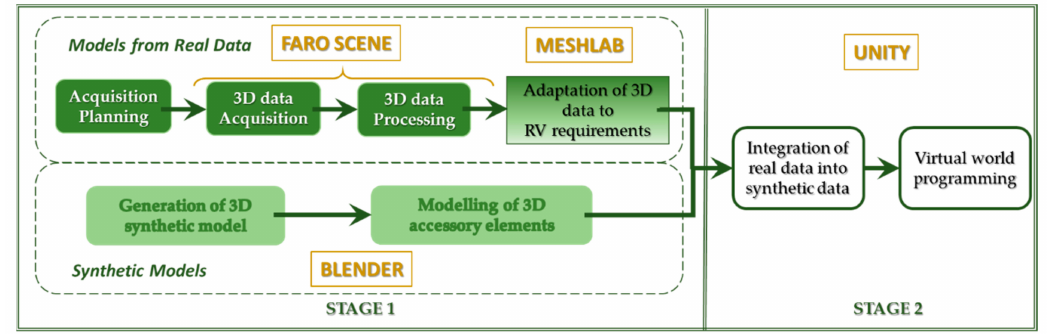
Figure 2. Scheme of the procedure performed to build the virtual reality (VR)